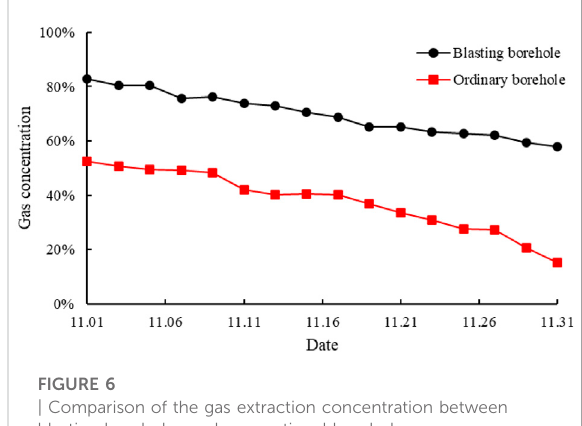
FIGURE 6 | Comparison of the gas extraction concentration between blasting boreholes and conventional boreholes.